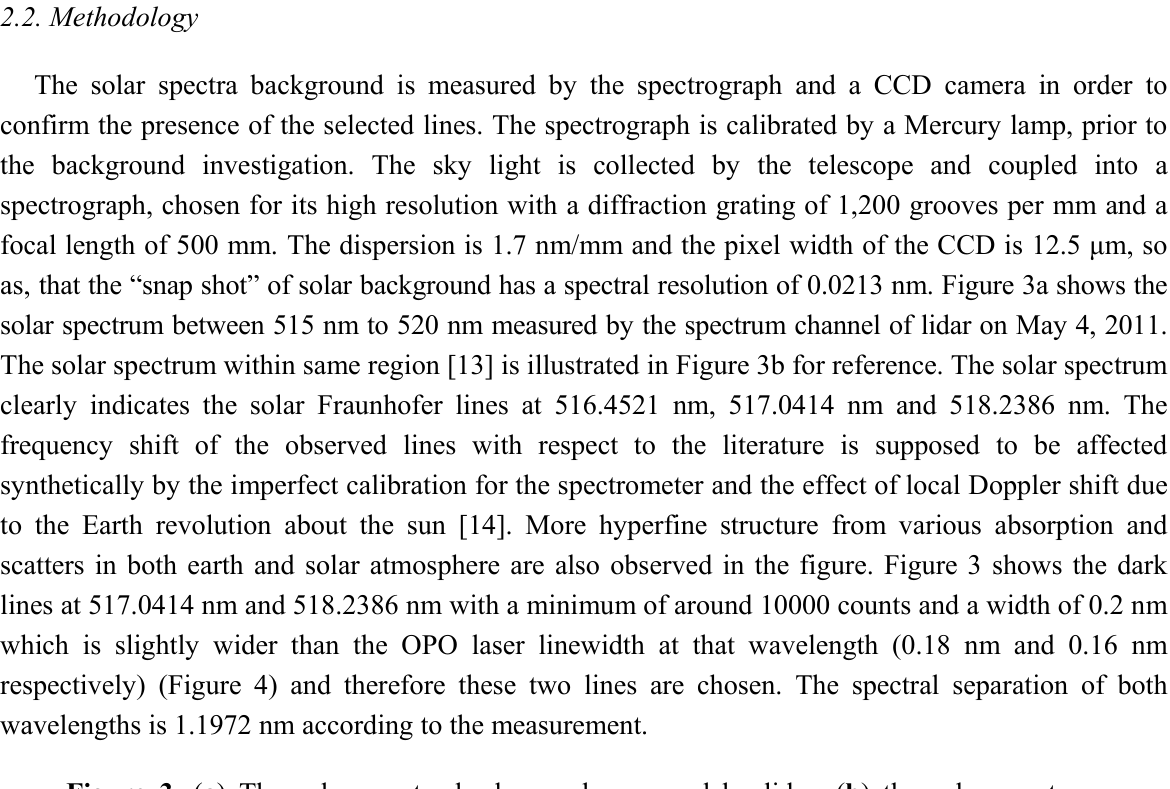
Figure 3. ( a ) The solar spectra background measured by lidar; ( b ) the solar spectrum provided by Kurucz 2010